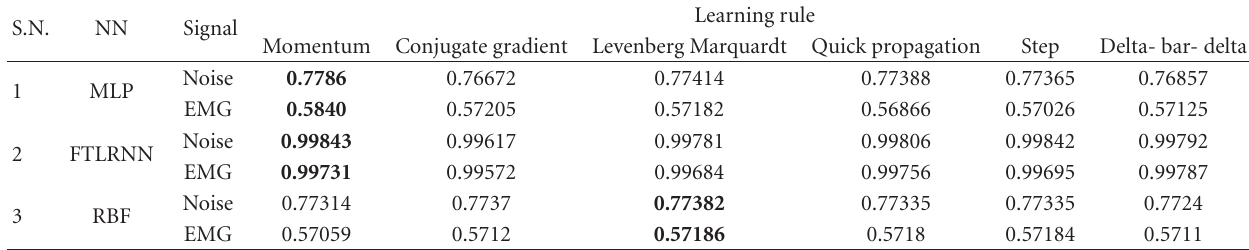
Table 13: Selection of optimal learning rule for various NN models on test dataset.